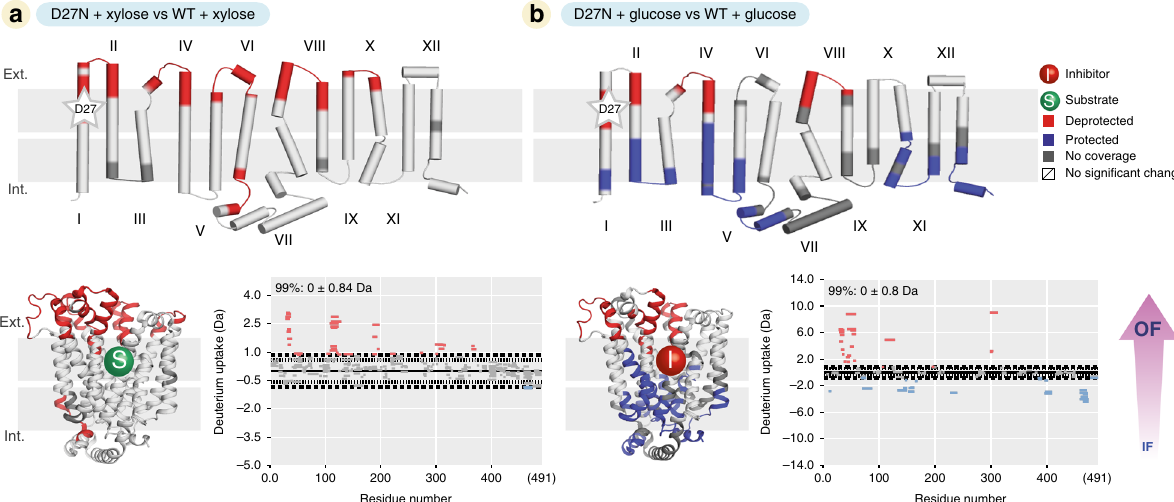
Fig. 4 Conformational transition of XylE through combined effect of substrate binding and mutation. a Δ HDX map and Woods plot between XylE D27N with XylE WT in the presence of substrate (xylose). b Δ HDX map and Woods plot between XylE D27N and XylE WT in the presence of inhibitor observation of a similar loss in TM1 helicity (residues I31-G33) for XylE in IF-occluded (PDB: 4JA3) and IF-open (PDB: 4JA4) states. To identify the molecular mechanisms leading to such differences between glucose and xylose binding, we carried out a detailed analysis of residue rearrangements happening at the between TM1 and speci fi c and ordered water molecules disappear sugar-binding site. The dihedral angles of the residues involved in substrate binding were calculated (Supplementary Fig. S9). Only minor differences between xylose- and glucose-bound states were observed with the notable exception of residues N294 and Q168. Both residues are pointing away from xylose (Fig. 6b) but towards glucose (Fig. 6c). In contrast, these residues point away from the ligand-binding site in XylE in IF conformation.